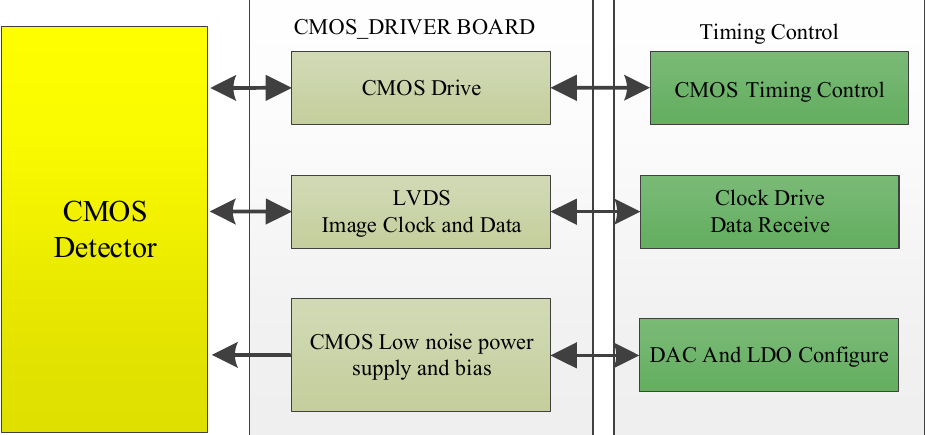
Figure 5. The signal flow block diagram of the CMOS driver board.